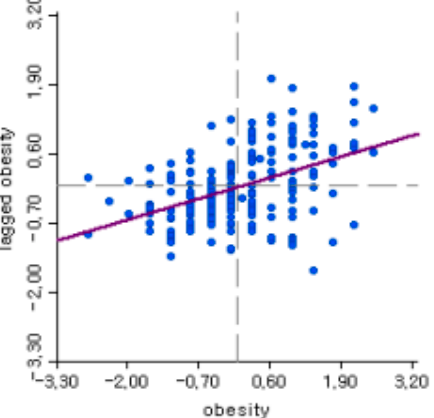
Figure 2. Moran’s I for obesity (Moran’s I value = 0.303).